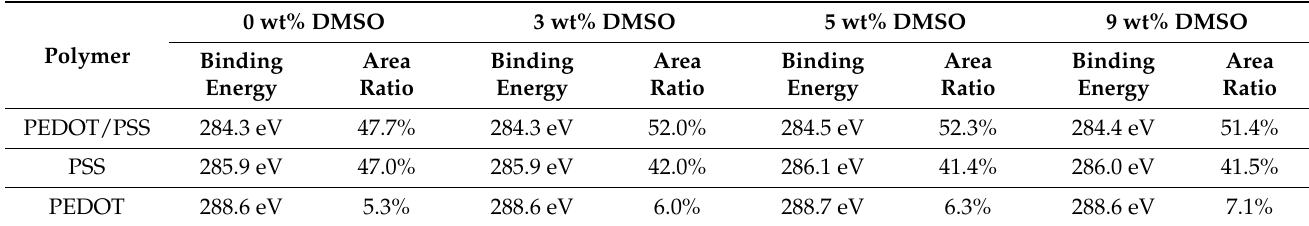
Figure 6. C(1s) core-level spectra of pristine and 9 wt% DMSO paste film. Table 2. Area ratio of various components of the C(1s) signal.